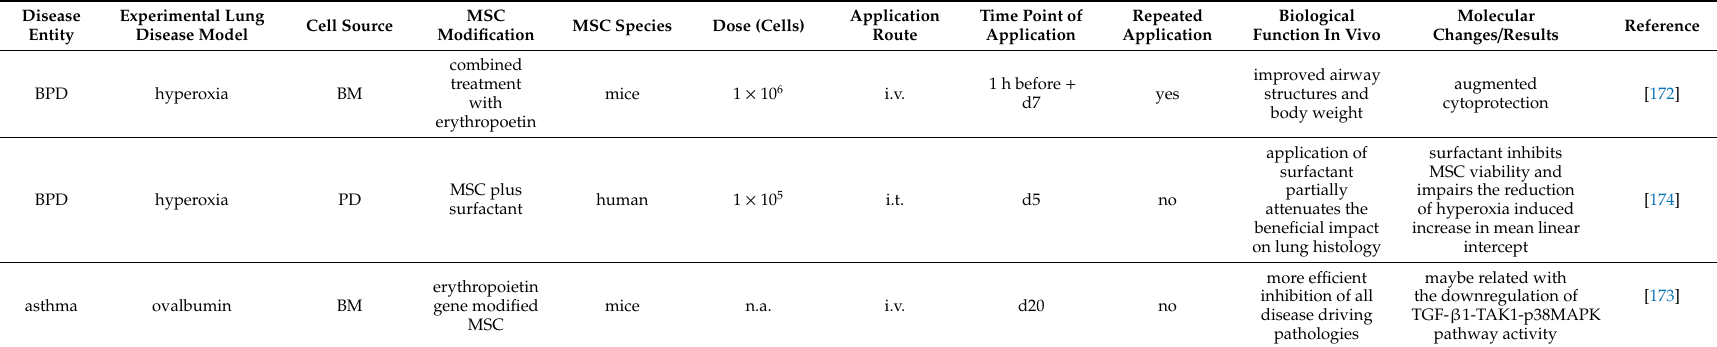
Table 8. Summary of relevant preclinical studies in rodents intended to improve the therapeutic e ffi cacy of MSC by co-treatment with